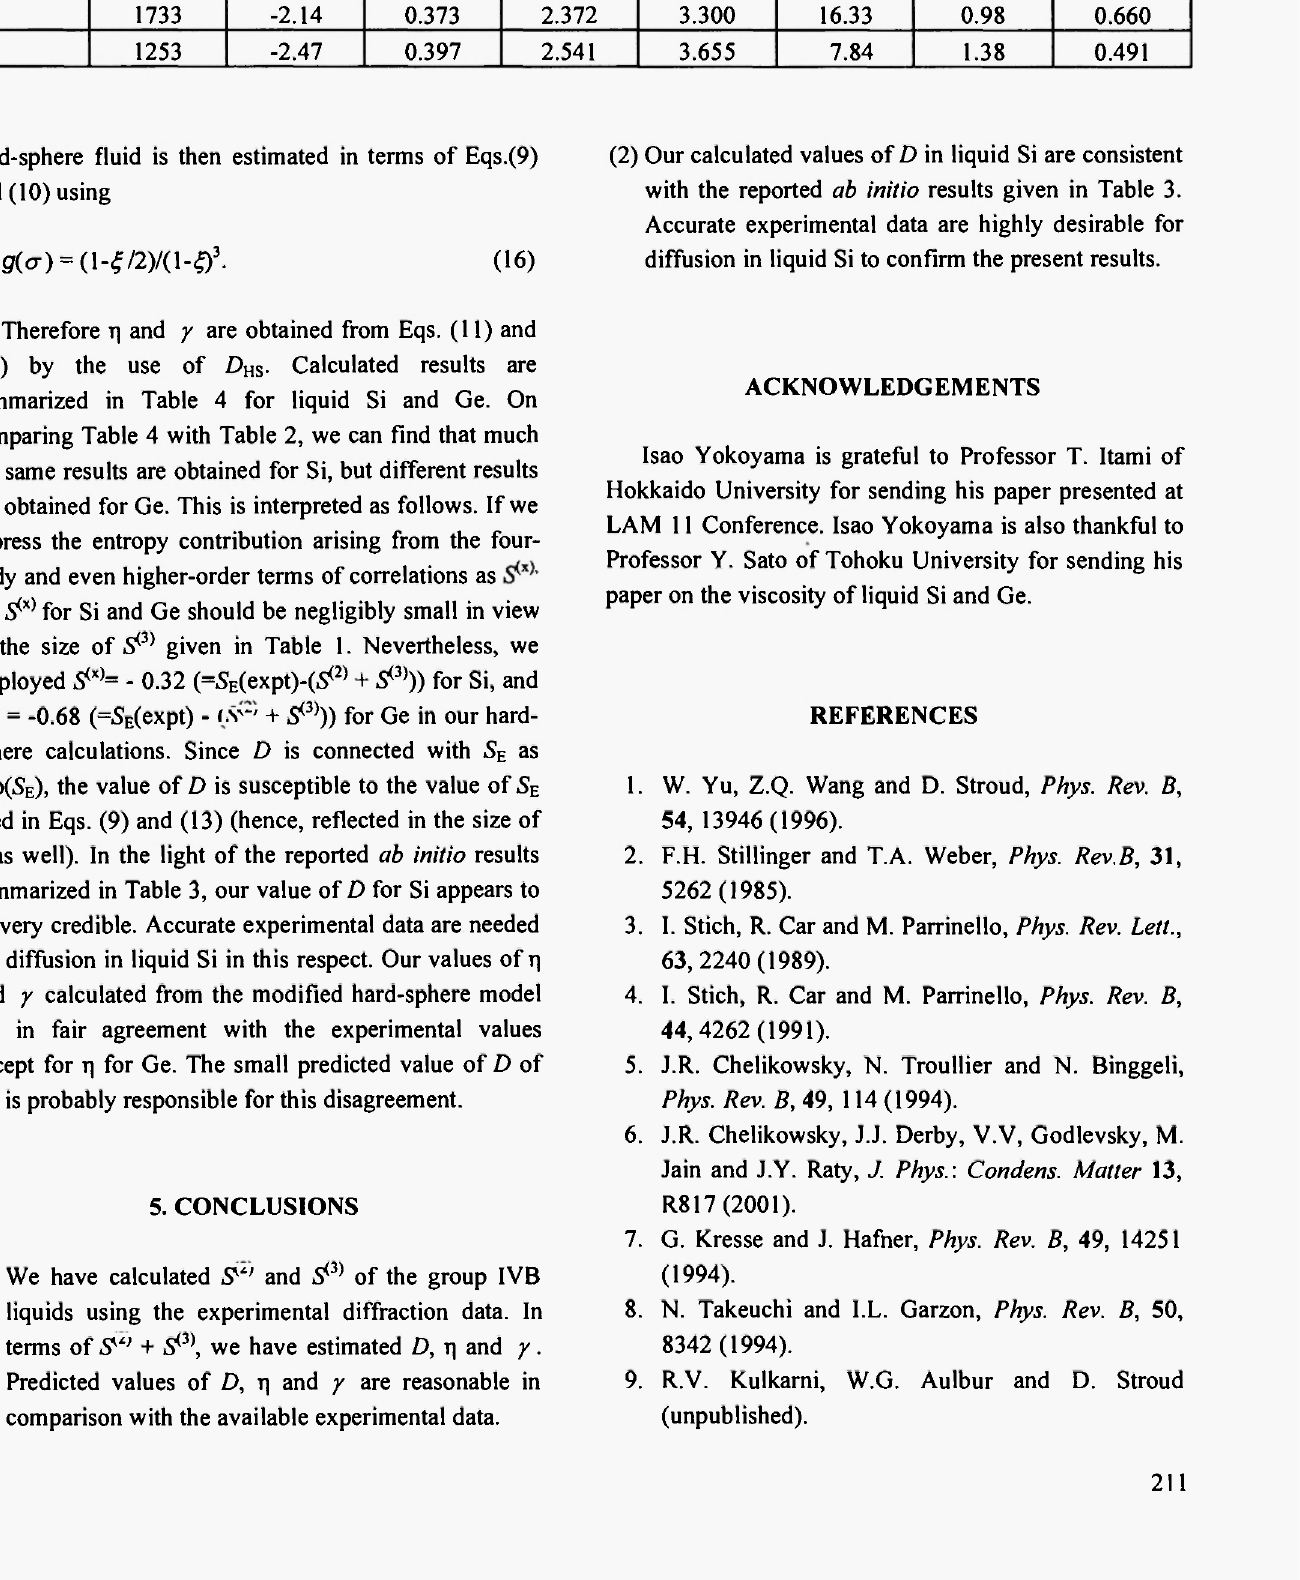
D, η and γ in liquid Si and Ge calculated from the modified hard-sphere